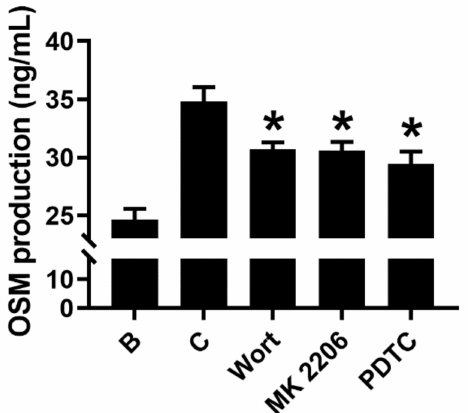
Figure 2. Inhibition of OSM levels by each inhibitor. dHL-60 cells (5 × 10 5 ) were pretreated with each inhibitor for 1 h and then stimulated with GM-CSF (5 ng/mL) for 4 h. OSM levels were measured